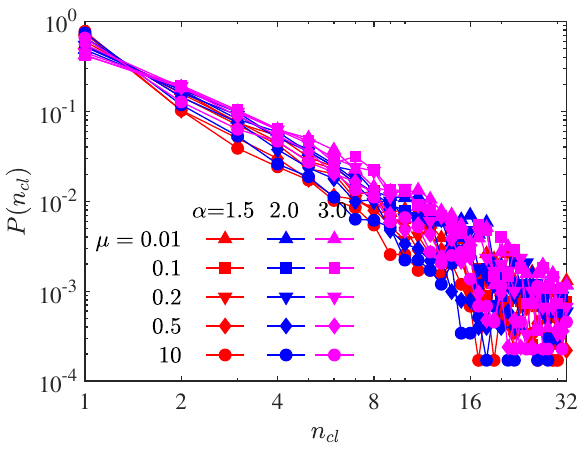
Figure 5. The cluster size PDFs, P ( n cl ), for various aspect ratios α and intergranular friction coe ffi cients µ .